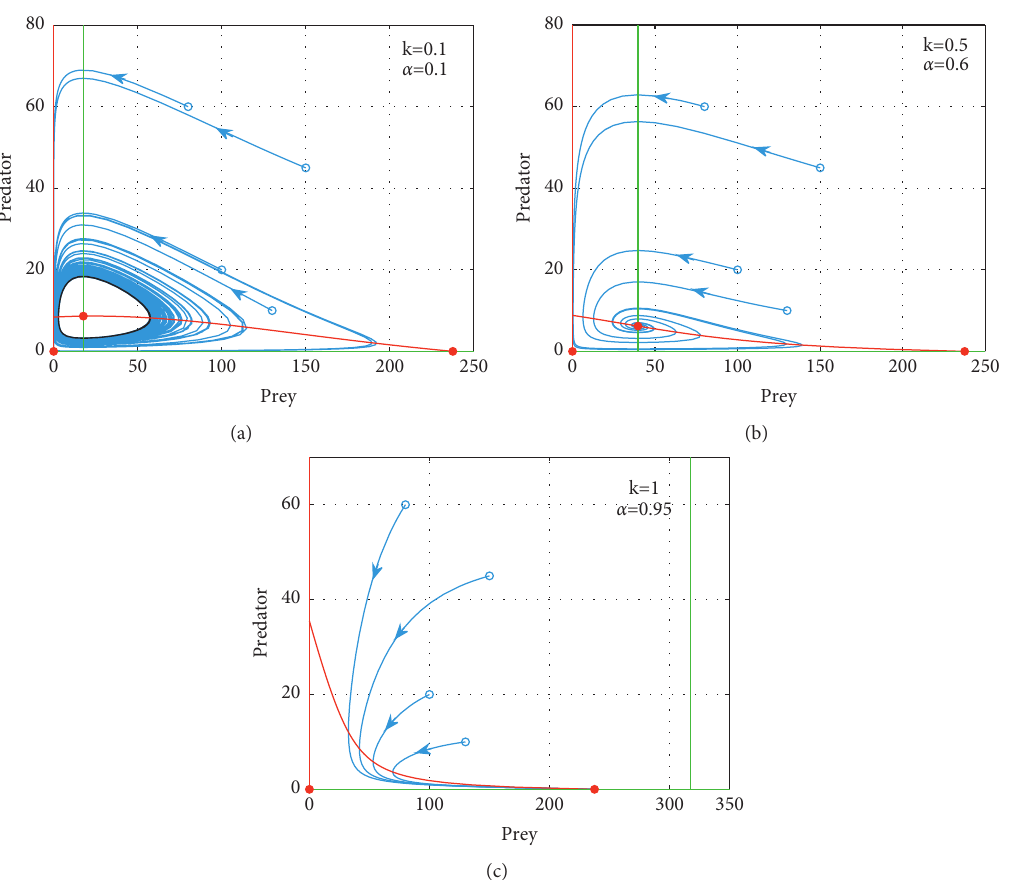
Figure 4: Phase portrait for different representative values of α and k taken from each region of Figure 3. In each figure, all the steady states, specified by small red-coloured filled circles, are the intersection of the prey nullclines (red-coloured curves) and the predator nullclines (green-coloured curves). Trajectories (blue-coloured curves) are drawn for different initial conditions and all the initial conditions are marked by small blue-coloured circles. The black-coloured orbit represents a stable limit cycle that occurs due to supercritical Hopf � 2 . 8 , η � 0 . 4 ,d � 0 . 9 ,a � 0 . 008 ,c � 0 . 15 , h � 0 . 08 , θ � 0 . 3 ,m � 0 . 6 . 􏼈 􏼉 . (a) E bifurcation. Other set of parameter values is r 0 (0,0) and E 1 1 (237.5,0) are unstable; limit cycle occurs around E 2 (17.7,8.6). (b) E 0 (0,0) and E 1 (237.5,0) are unstable; E 2 (39.7,6.2) is globally asymptotically stable. (c) E 0 (0,0) is unstable; E 1 (237.5,0) is globally asymptotically stable.